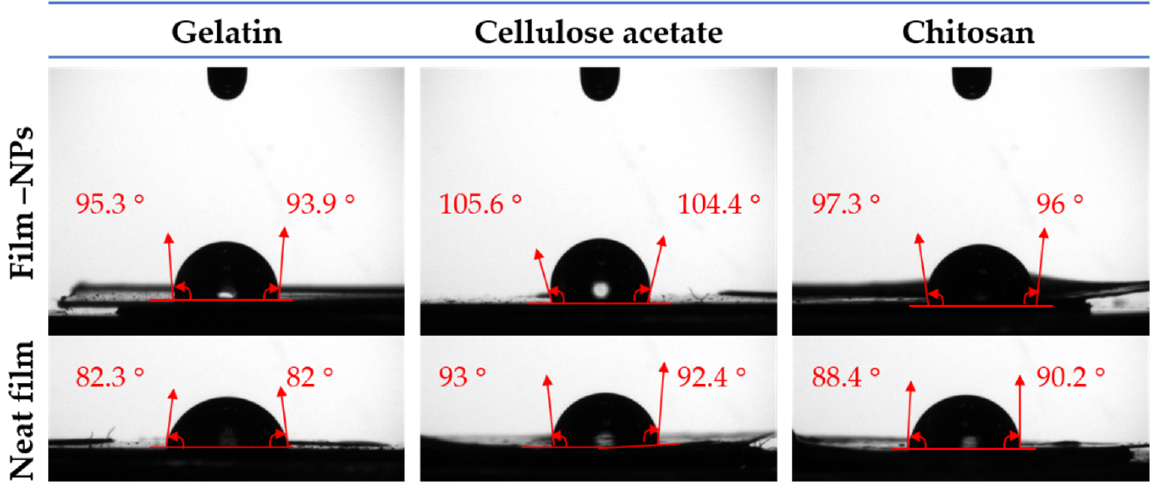
Figure 3. The water contact angles photographs of the different films (gelatin-based, cellulose acetate- Figure 3. Photographs of the different films (gelatin-based, cellulose acetate-based, and chitosan- based, and chitosan-based composite films) with Fe x O y (1.0% w / w ). Neat films (gelatin-based, based composite films) with Fe x O y (1.0% w / w ). Neat films (gelatin-based, cellulose acetate-based, cellulose acetate-based, and chitosan-based films) without Fe x O y nanoparticles incorporated were and chitosan-based films) without Fe x O y nanoparticles incorporated were included as references. included as